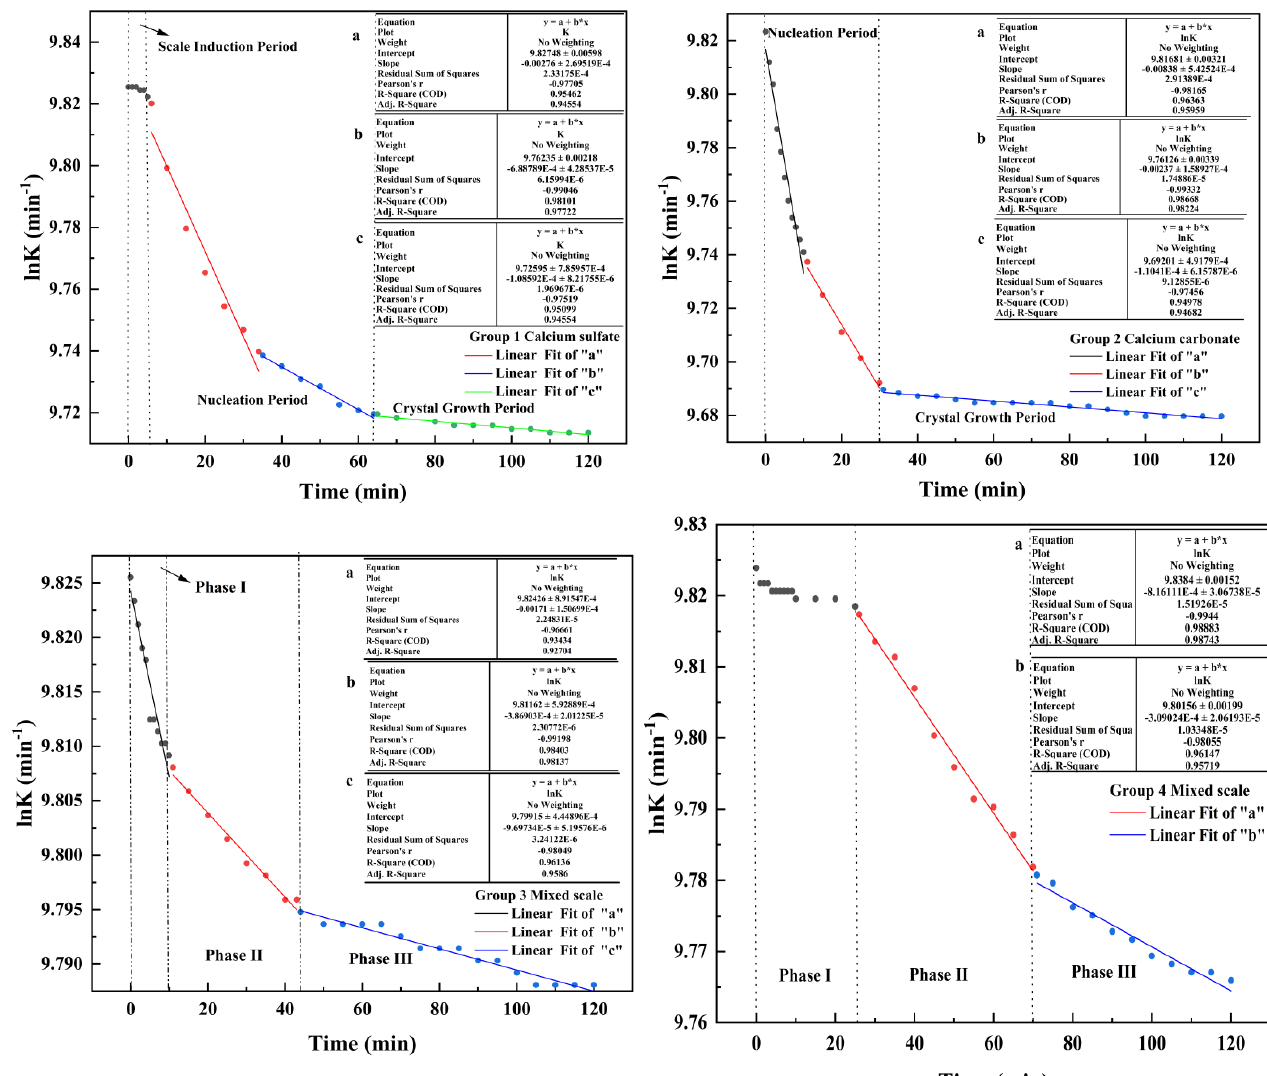
Figure 2. The variation curve of conductivity of solution with time, ( a ) in 120 min; ( b ) first 20 min.